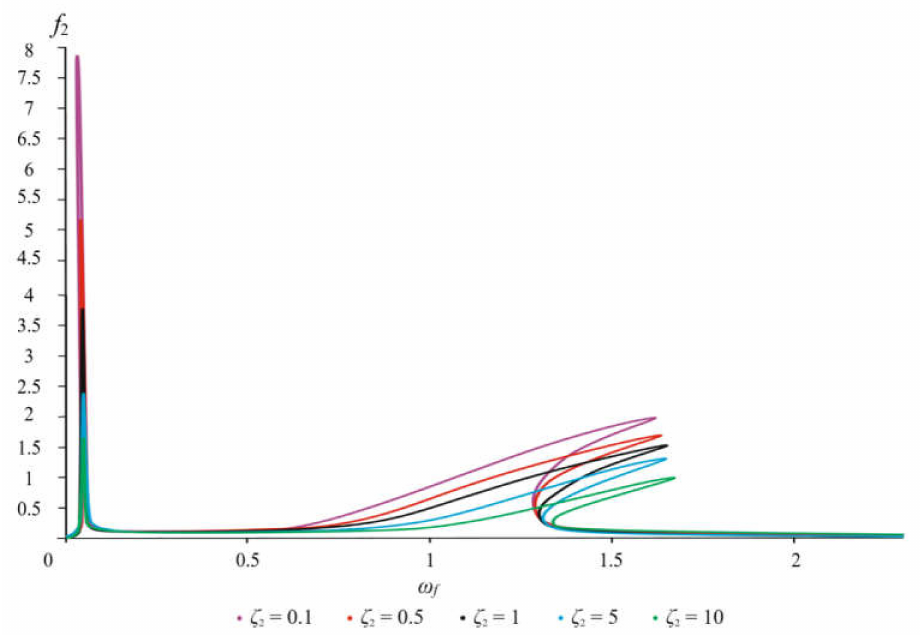
Figure 8. The amplitude-frequency characteristic of the foundation at different values of damping coefficients.